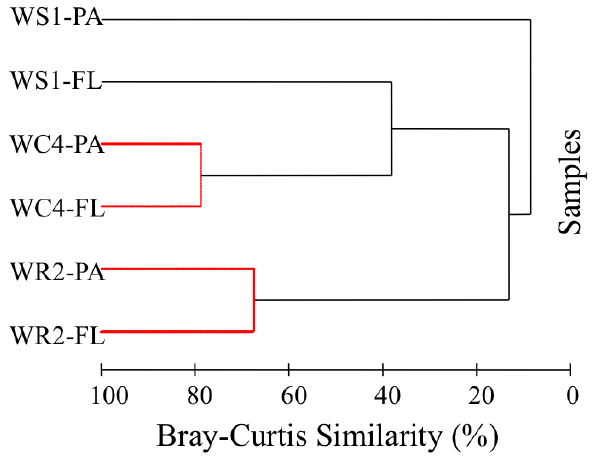
Fig. 5. UPGMA dendrograms based on Bray–Curtis similarities of DNA 454-tag sequences. PA: particle-attached bacteria; FL: free- living bacteria; S: sea; C: coast; R: river. Single clusters with non- significant differences between samples are marked in